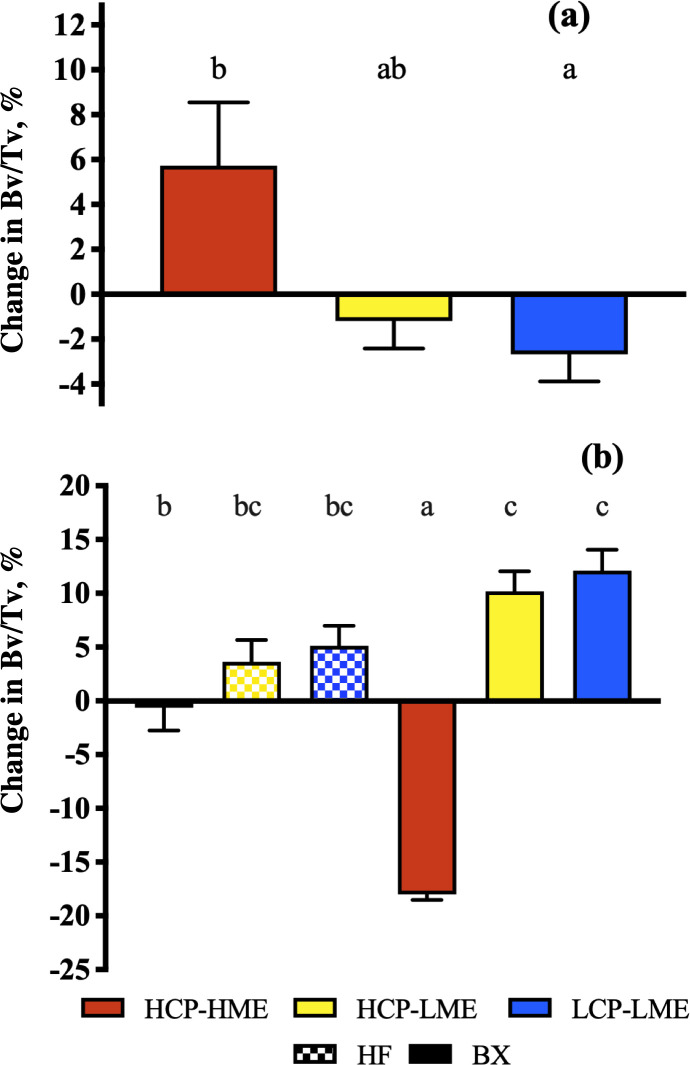
Change in trabecular bone volume (Bv/Tv) of tuber coxae samples collected from Holstein-Friesian (HF) and Brahman crossbred (BX) steers fed different nutritional treatments (Phase 1; a) and during re-alimentation (Phase 2; b).During Phase 1, the interaction between genotype and nutritional factors was not significant so the means of both genotypes were pooled by nutritional treatment. Data are expressed as mean ± SEM. Means with different letters are significantly different (Tukey, P < 0.05).